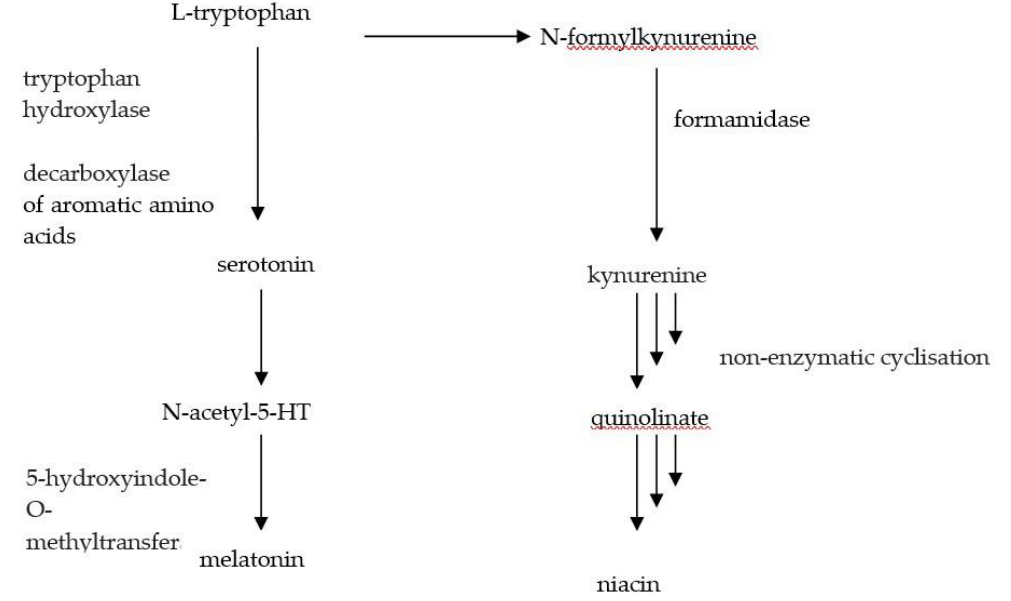
Figure 2. Transformation of tryptophan.